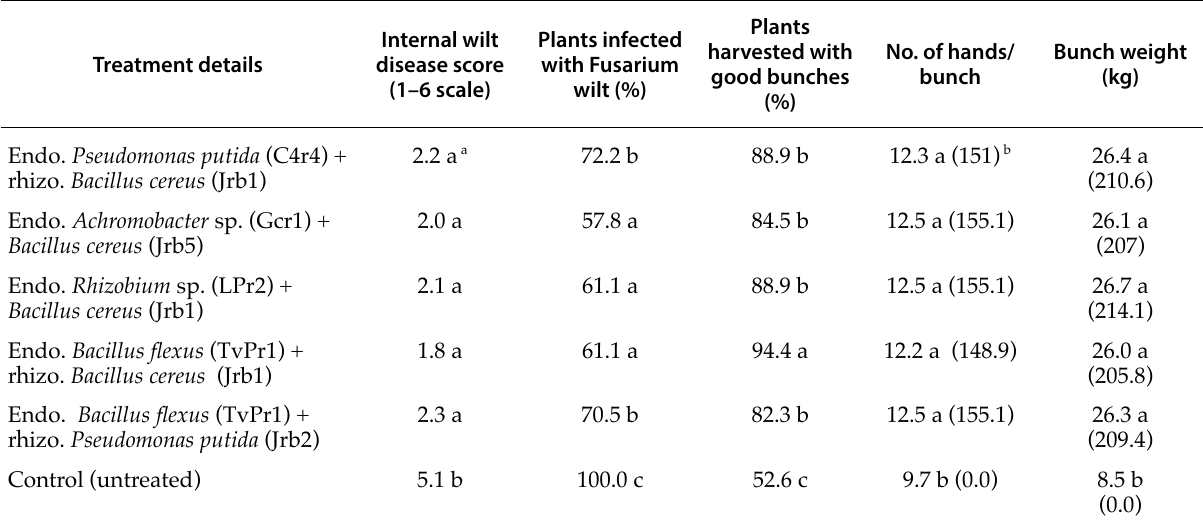
Plants Plants infected harvested with No. of hands/ Bunch weight with Fusarium good bunches bunch (kg) (1–6 scale) wilt (%) (%)